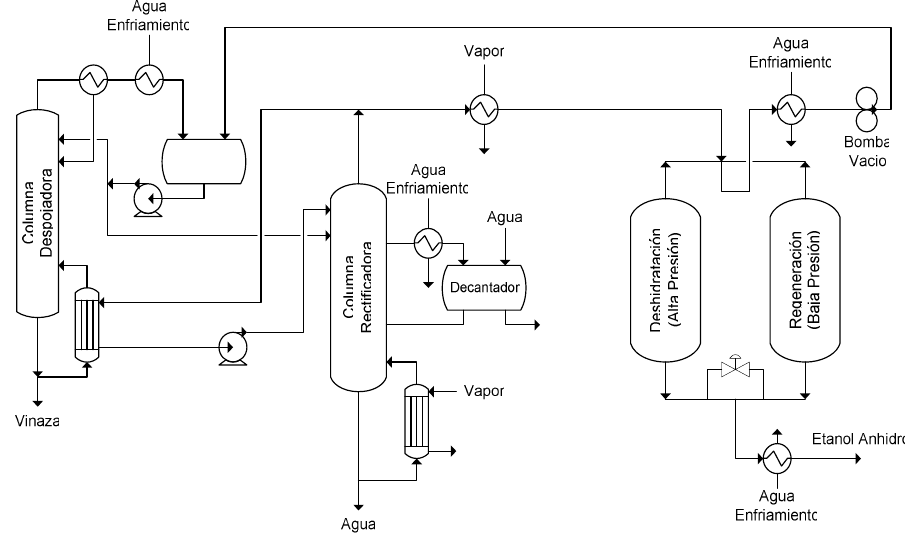
Figure 1. Generalized scheme of the dehydration process of ethanol 5